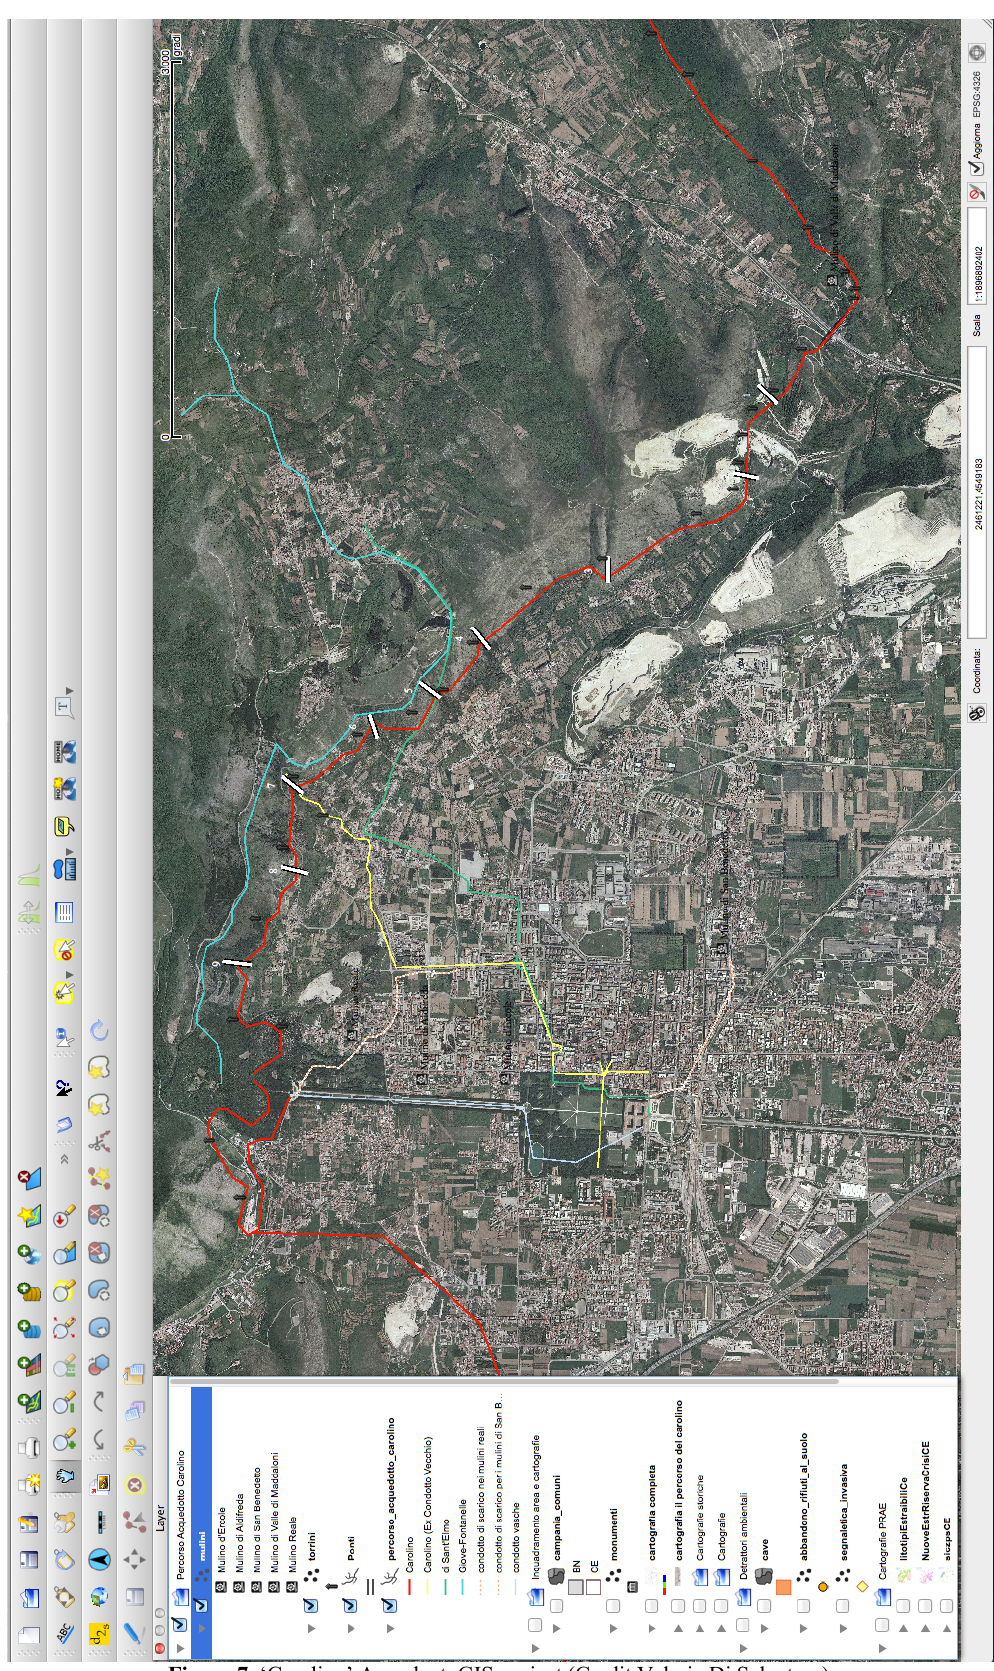
Figure 7 . ‘Carolino’ Aqueduct. GIS project (Credit Valeria Di